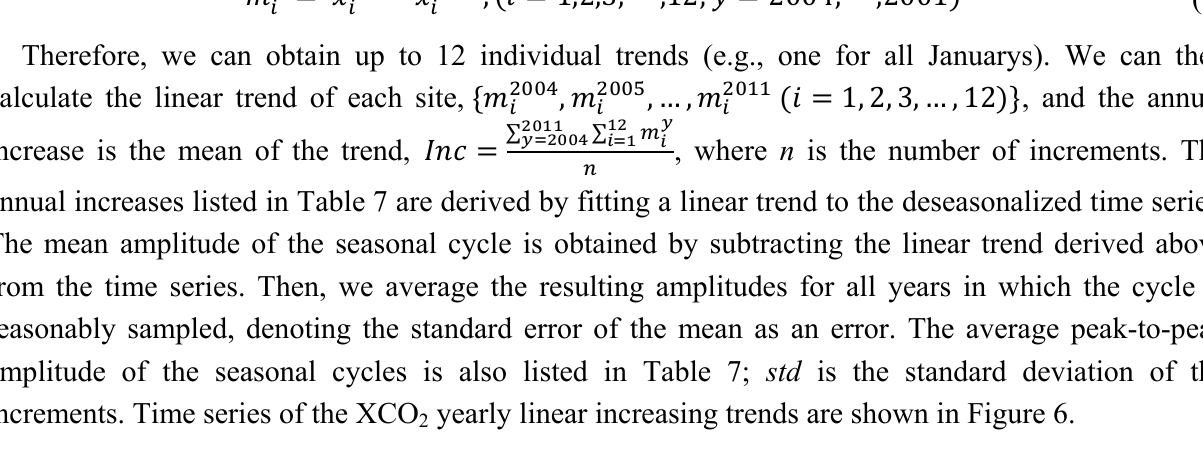
Table 7. Annual increase and seasonal cycle amplitude at the analyzed TCCON sites.